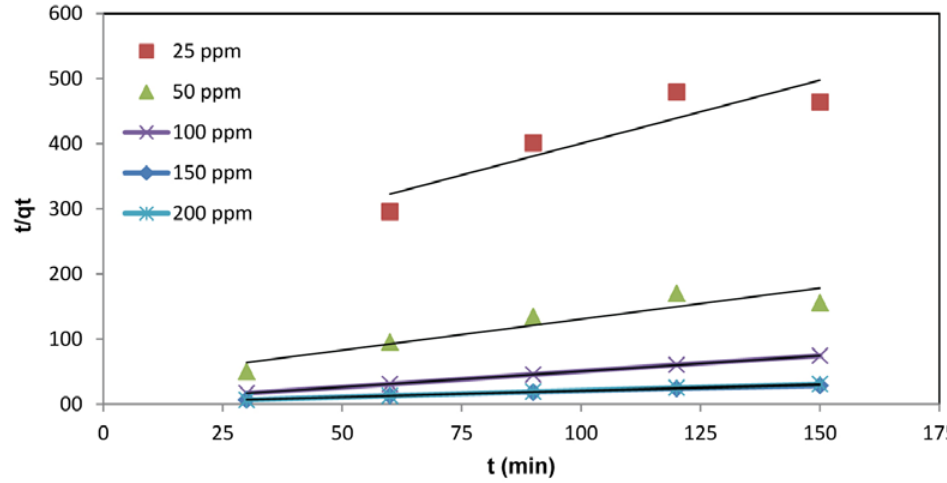
Figure 5. Pseudo-second –order plots at different initial 2.4 DCP concentrations (pH: 2; biomass: 1 g, temperature 20 ± 0.5, agitation rate: 125 rpm)